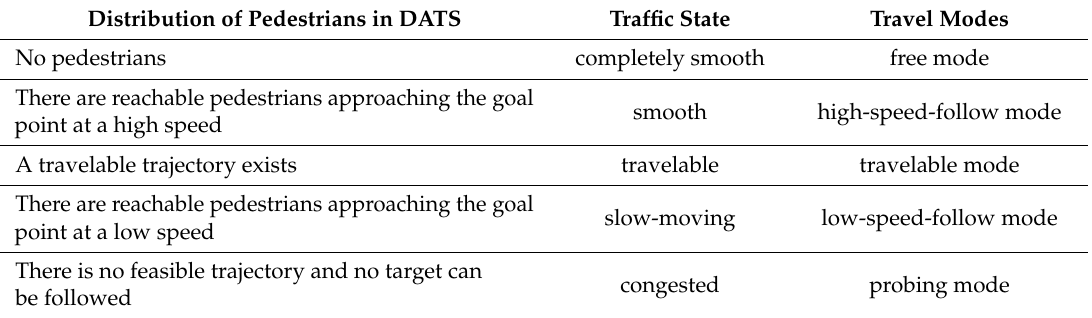
Table 1. Travel modes for different traffic